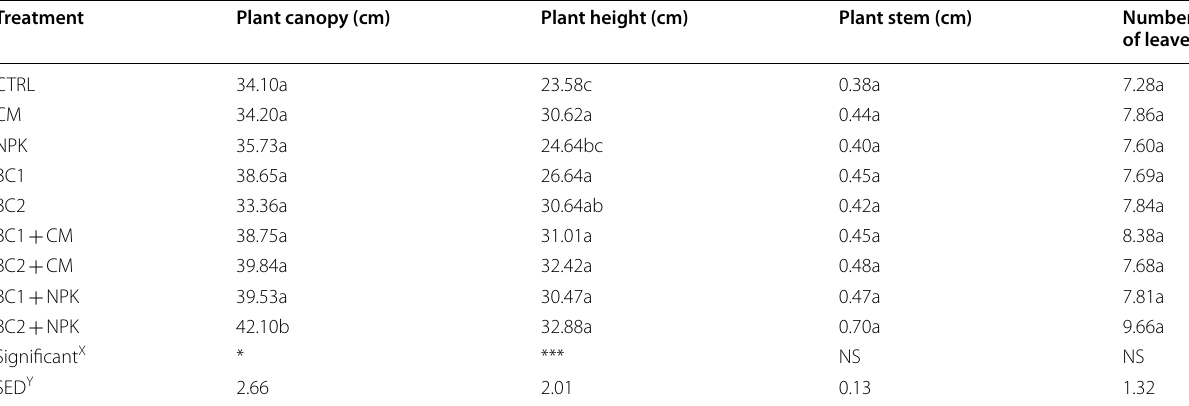
Significant X and SED Y effects were obtained from one-way analysis of variance: *, **, *** significant at P < 0.05, P < 0.01 , and P < 0.001 , respectively. See Table 2 for a description of the treatments; Means followed by the same letter in each column are not significantly different at